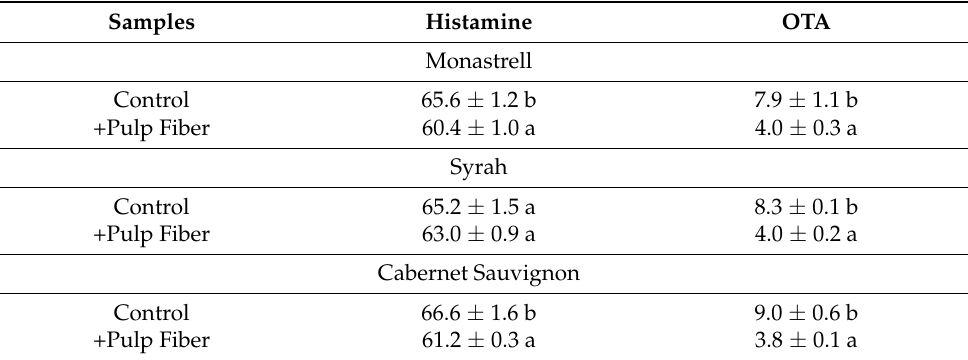
Table 4. Concentration of histamine and OTA in the wines with and without treatment with the fining agent (pulp